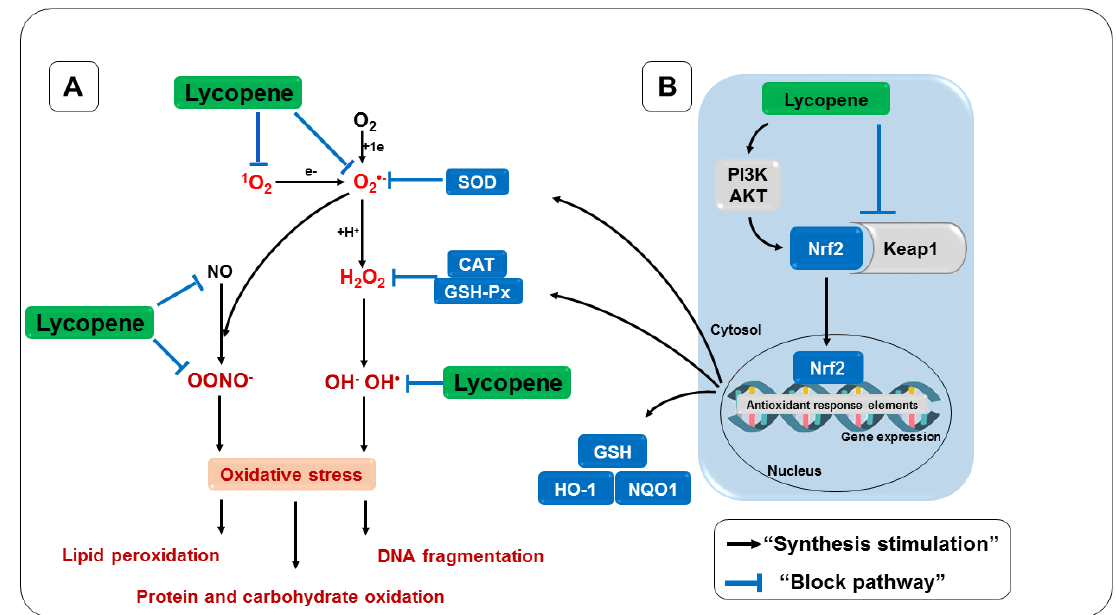
Figure 8. Antioxidant effect of lycopene. ( A ) Direct antioxidant activity. ( B ) Indirect antioxidant activity. Keap1, Kelch-like inhibitory protein 1; Nrf2, erythroid nuclear factor 2; GSH, glutathione; SOD, superoxide dismutase; CAT, catalase; GSH-Px, glutathione peroxidase; PI3K/AKT, phosphoinositide 3-kinase/AKT.